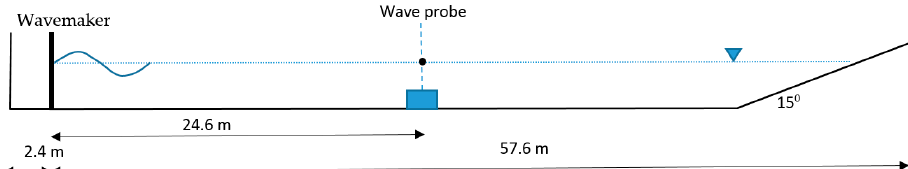
Figure 7. Experimental setup with and without obstacle. Table 3. Numerical setting in DualSPHysics.